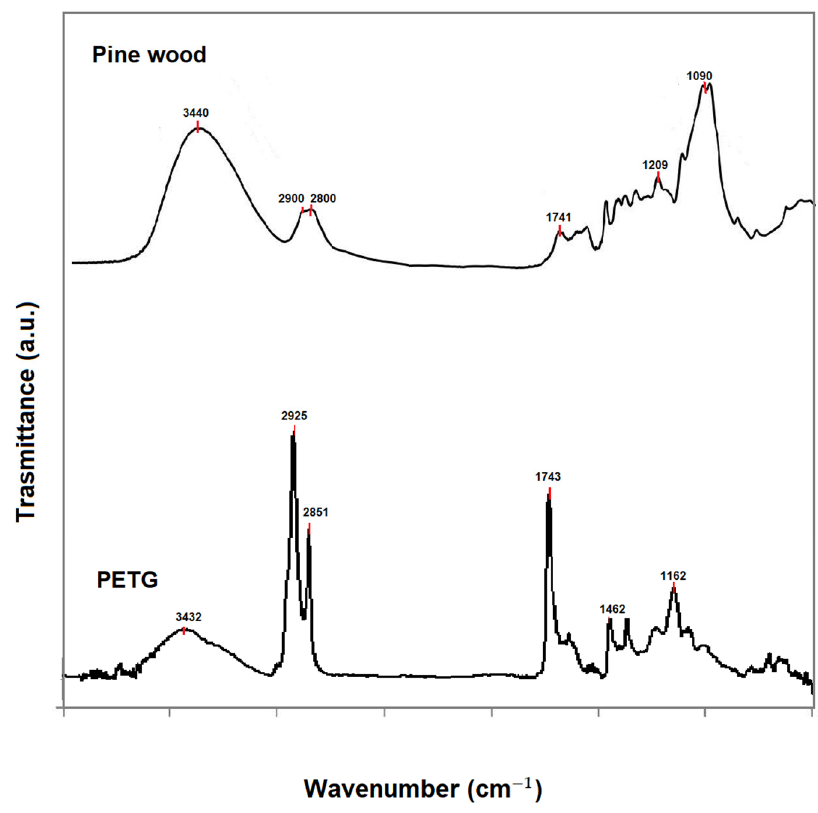
Figure 4. FTIR spectra of pine wood and PETG, and main infrared bands.